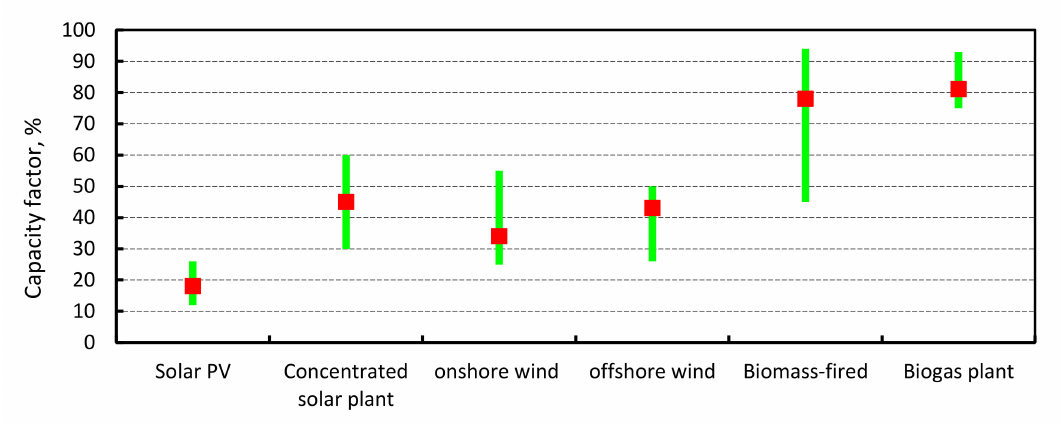
Figure 5. Capacity